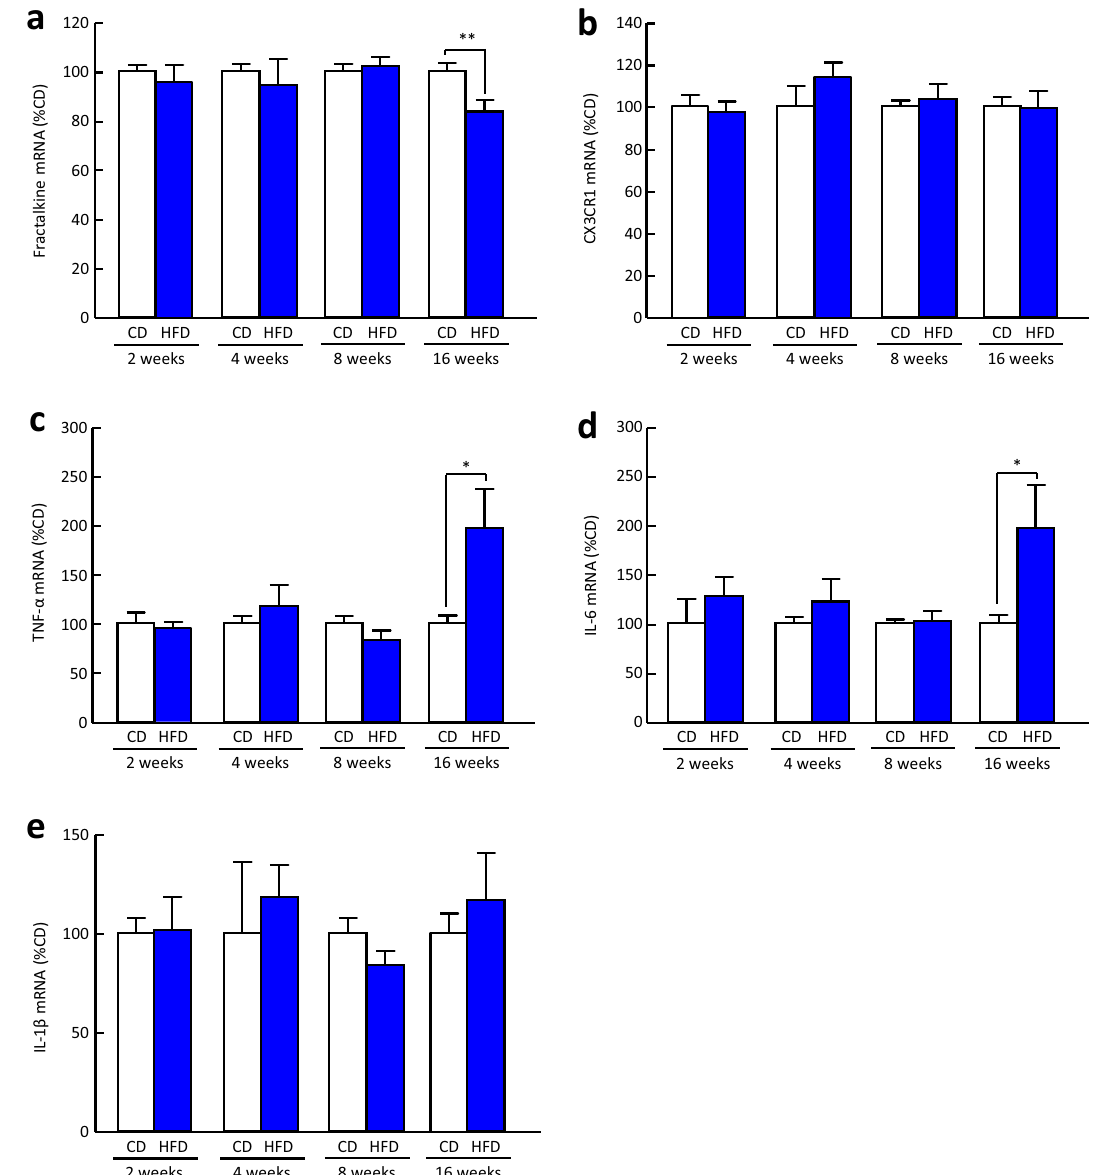
Figure 5. Changes in mRNA expression of fractalkine, CX3CR1, and proinflammatory cytokines in the hypothalamus of mice fed a HFD. ( a ) Fractalkine, ( b ) CX3CR1, ( c ) TNF-α, ( d ) IL-6, and ( e ) IL-1β mRNA expression in the hypothalamus of mice fed a HFD for 2, 4, 8, and 16 weeks. Results are expressed as mean ± SEM for 5–16 mice. Significant difference: * p < 0.05, ** p <